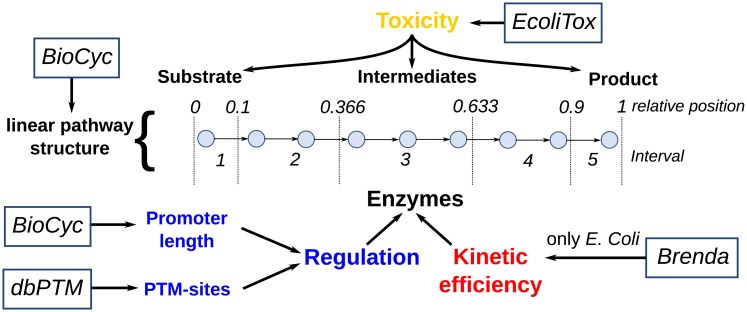
Overview of data and its processing for validation of optimization results.Rectangles depict the used databases and colors indicate, similar to the other figures, the considered pathway characteristics. A scheme of a 8-step linear pathway visualizes the binning into 5 intervals for the validation process.